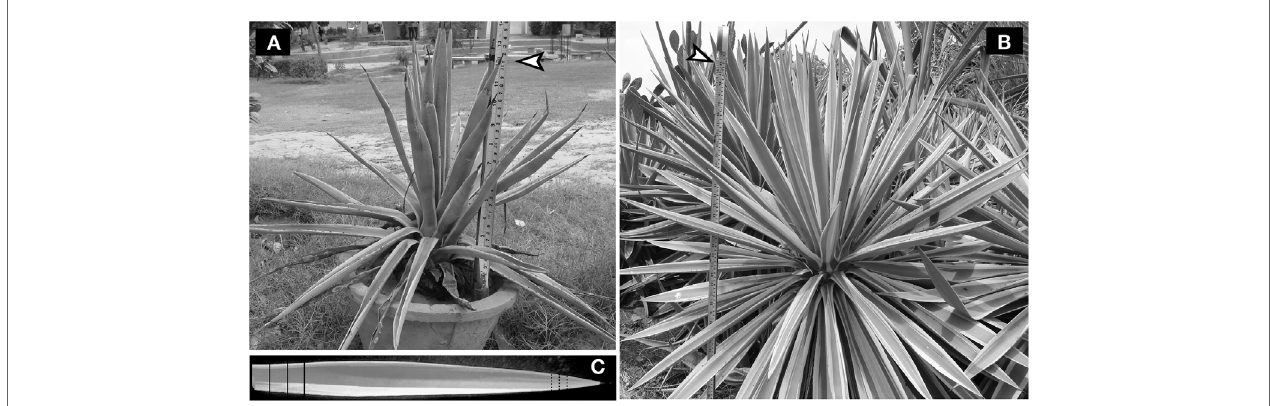
FigUre 1 | representative Agave angustifolia plants selected for larvicidal activity. Agave angustifolia plants with different heights, which denote their vegetative growth, were selected for analyzing the larvicidal activity in their leaf extracts. (a) Smaller size plants (12 ″ in height) growing in a pot or (B) a larger size plants (44 ″ in height) growing in an open field are shown here. (c) Agave angustifolia leaf depicting the pattern of slicing for crude extract preparation. Solid and dotted vertical lines indicate leaf areas proximal or distal to the stem, respectively. Black arrowheads indicate the height of each plant on an inch